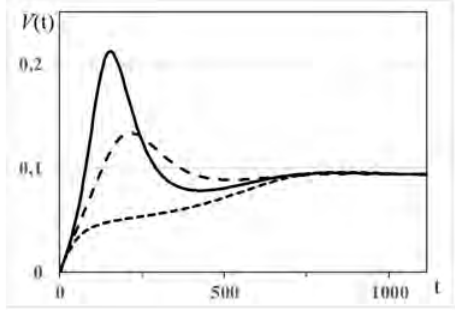
Fig. 12. Graphs of V ( t ) for non-oscillating dynamics for 3 different initial values ϕ ( a ) .